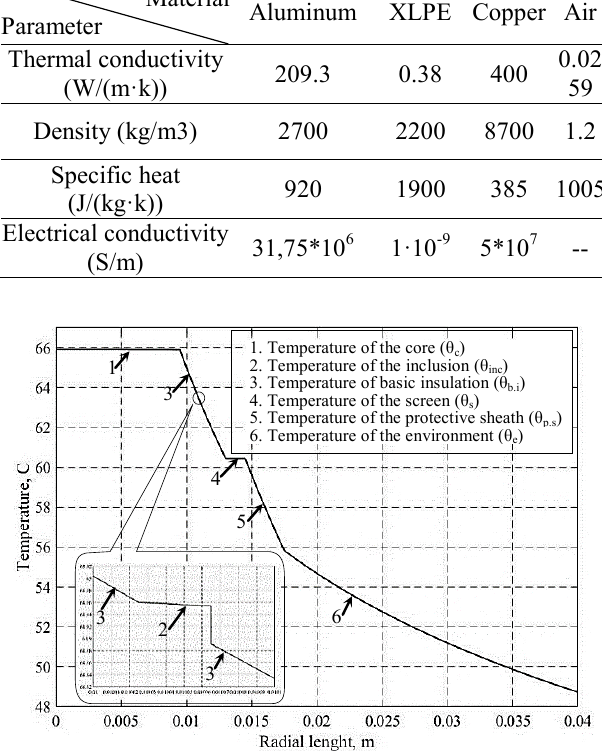
Figure 3. Graphs of the temperature distribution in the characteristic points of the cross section of CL